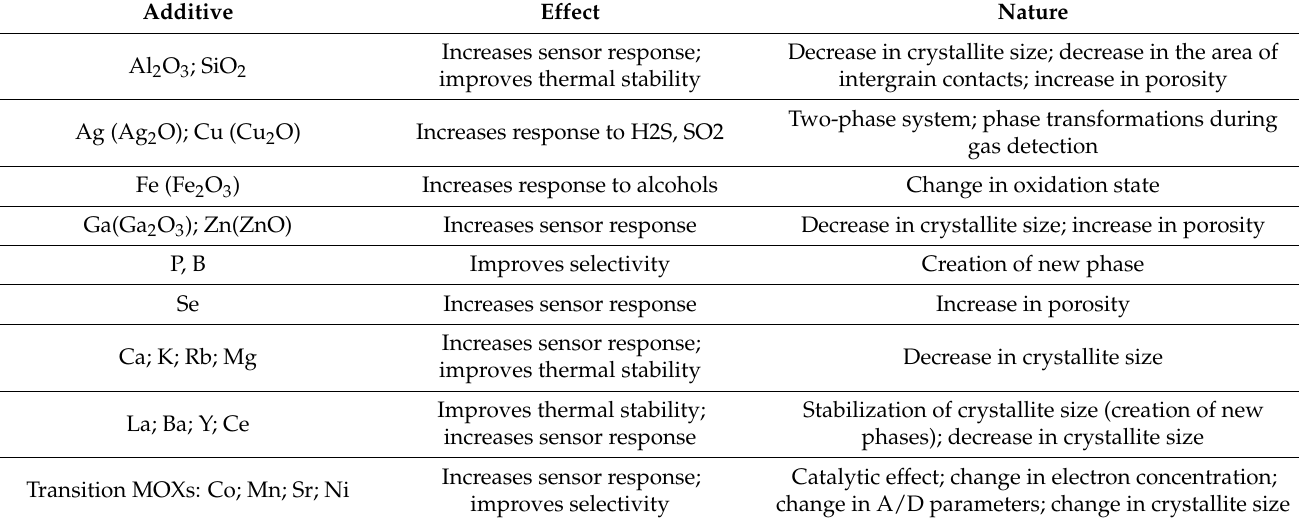
Table 5. Influence of additives (in oxide form) in metal oxide matrix on structural and gas sensing characteristics of SnO 2 - and In 2 O 3 -based sensors. Influence on the electrophysical characteristics, i.e., acceptor or donor behavior of the additives, is not